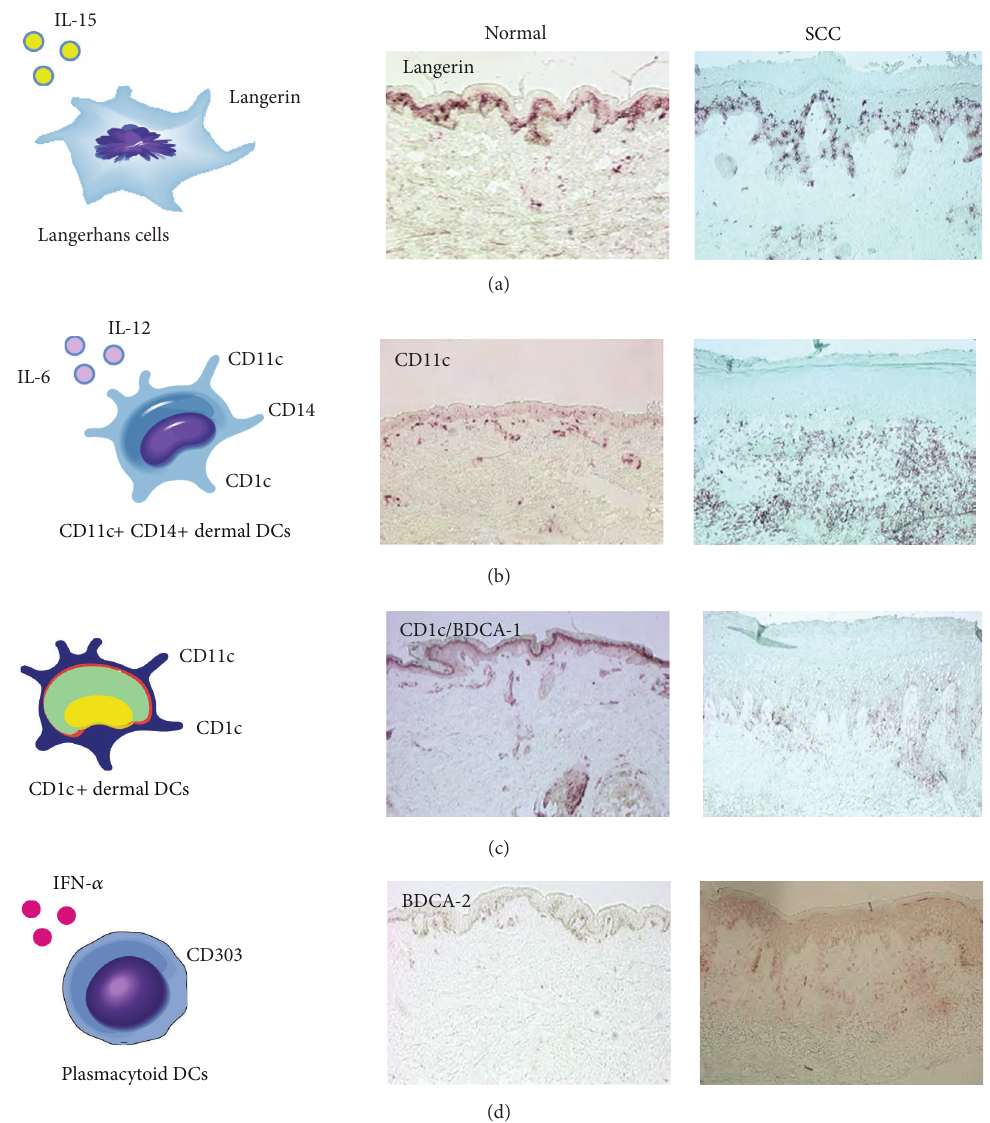
Figure 1: The distribution of cutaneous dendritic cell subsets in normal skin versus human squamous cell carcinoma (SCC). The human skin contains four main subsets of DCs which can be distinguished based on the differential expression of surface molecules in the steady state (left). Representative immunohistochemistry (right) demonstrating the relative distribution of DC subset markers: (a) CD207/Langerin, (b) CD11c, (c) CD1c/BDCA-1, and (d)